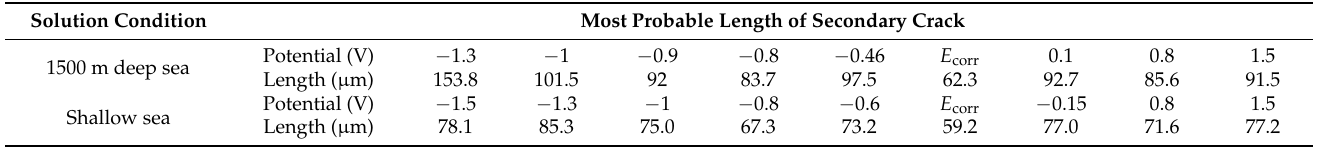
Table 2. Most probable length of secondary crack at various potentials in simulated deep–sea and shallow–sea